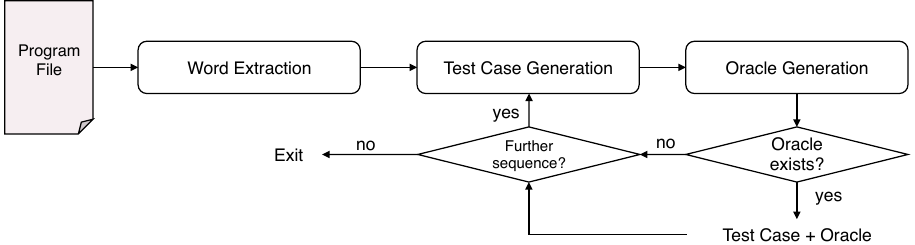
Figure 9. Test case generation. Given the word set defined by the programmer, the system generates all possible executable sentences along with the respective oracles.